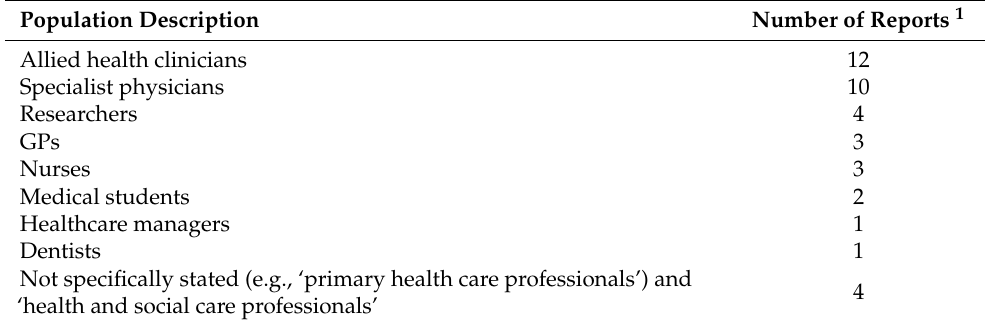
Table 2. Membership population of